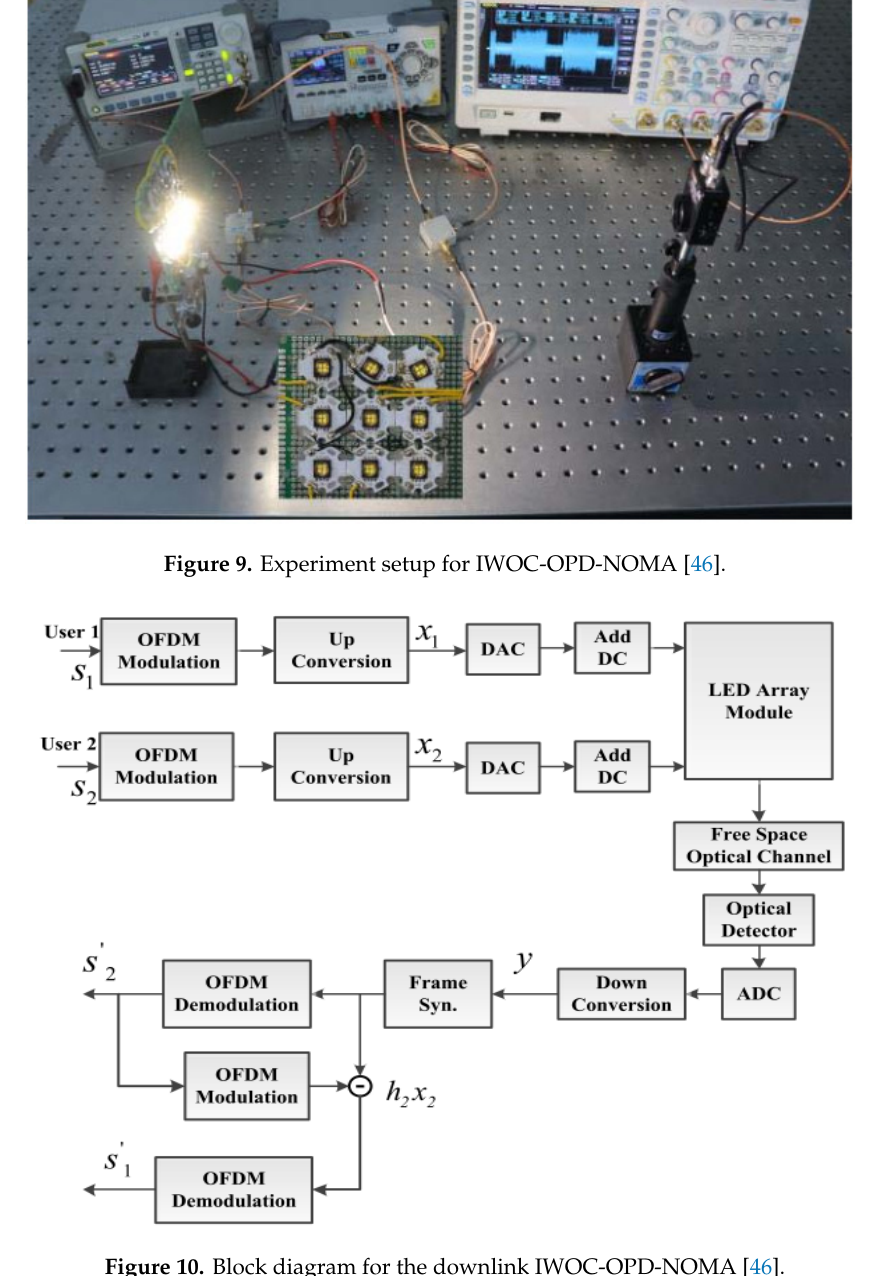
Figure 10. Block diagram for the downlink IWOC-OPD-NOMA [46].